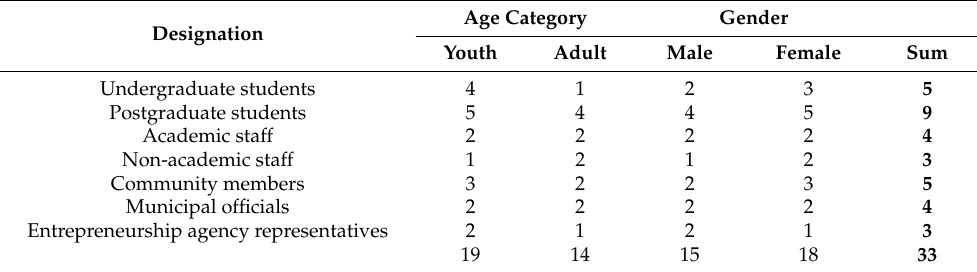
Table 1. Participant